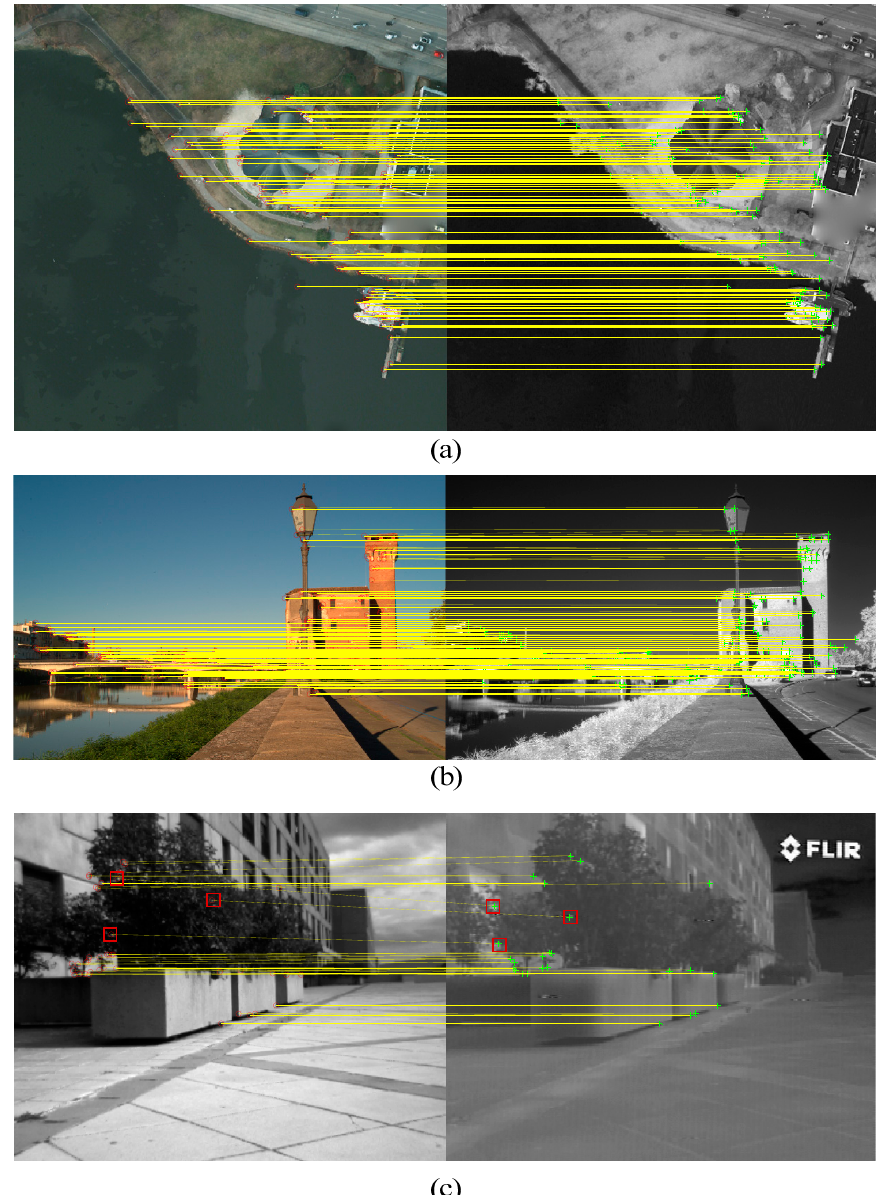
Figure 8. Sample two of feature matching results by the HOSM descriptor for the multispectral image pairs in three datasets. From top to bottom: matching results on ( a ) Potsdam dataset, ( b ) EPFL dataset, and ( c ) CVC dataset.